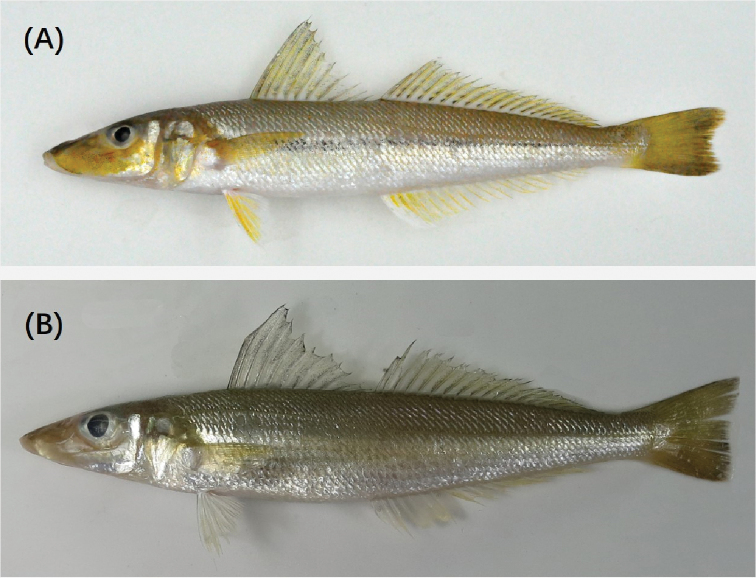
ASillago
nigrofasciata sp. nov., OUC_FEL178001, holotype, 151.2 mm SL, Fuding, China, BSillago
sihama, ZJOU_FEBL021131, 131.0 mm SL, Zhangzhou, China.